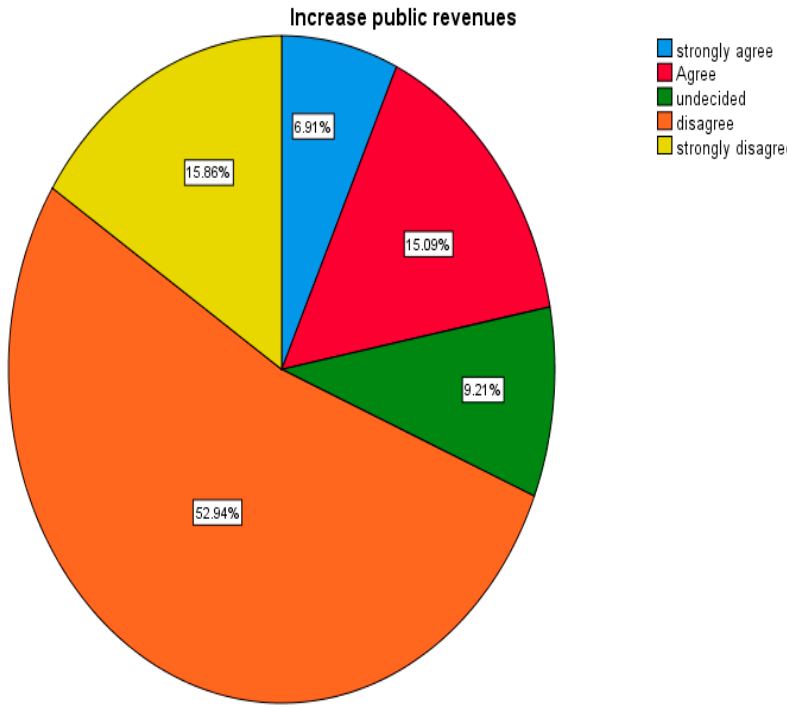
Figure 5. The response rates of household (HH) respondents on the public revenues of the towns (source: HH survey, 2022).